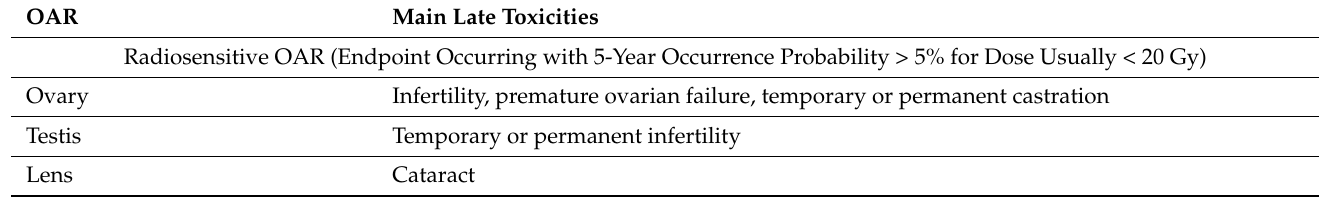
Table 1. Main late toxicities observed in practice according to the tissue radiosensitivity, assuming the homogenous irradiation of the structures. OAR = Organ At Risk. Reprinted by permission